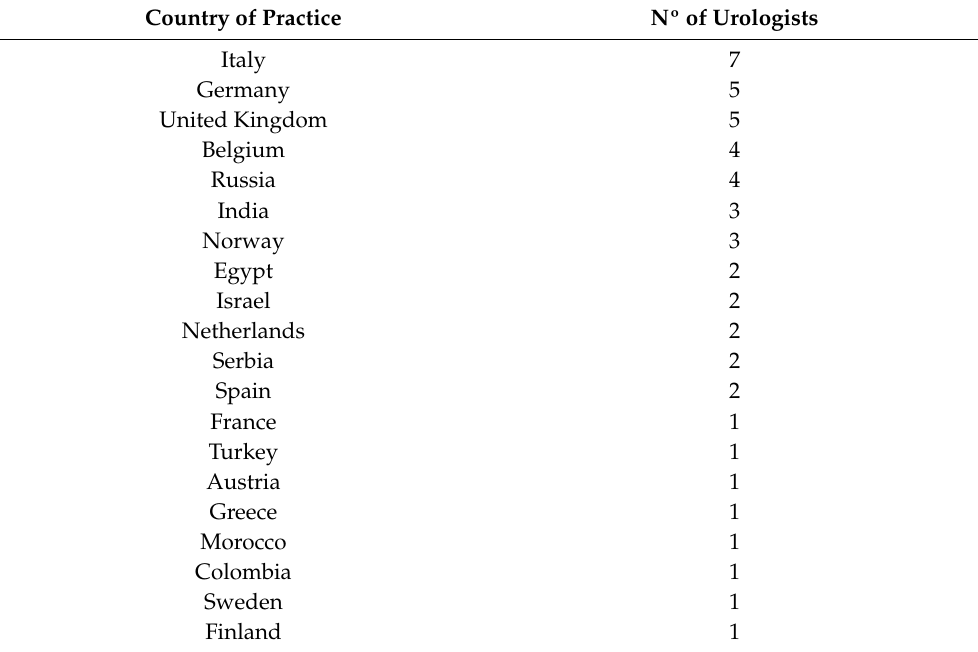
Table 2. Country of practice of ESGURS members participants.